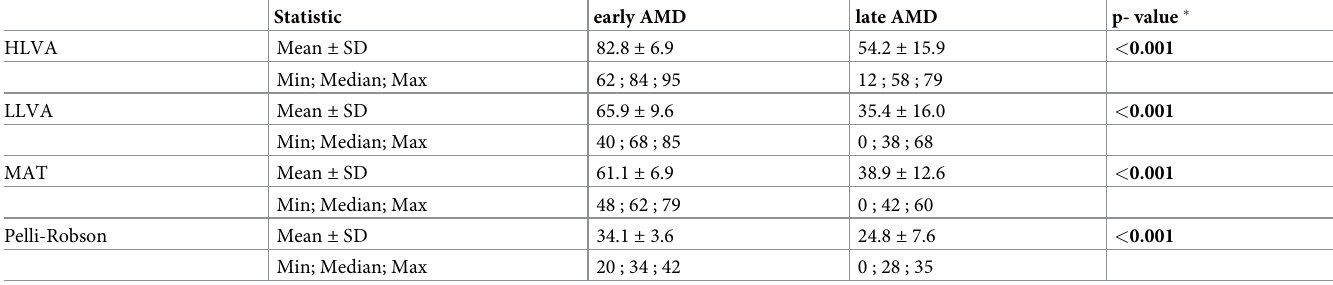
Table 2. Performance on visual function